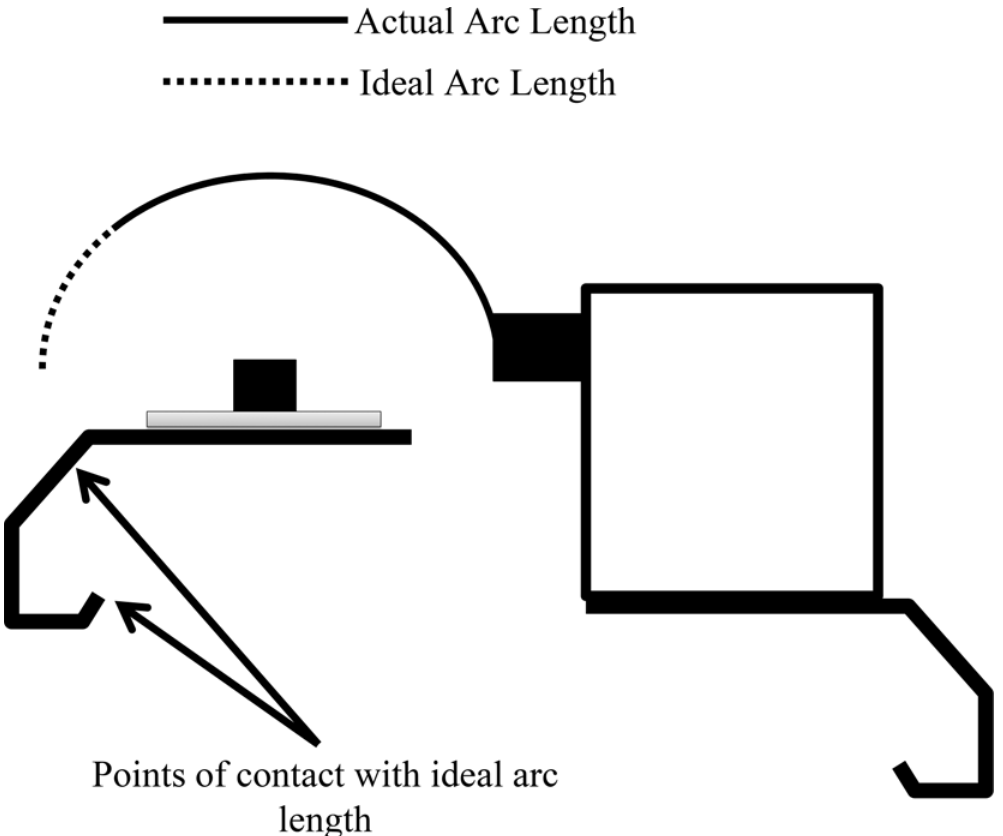
Figure 1. Difference between ideal arch length and actual, with points of contact that would not allow the use of the ideal arc length.